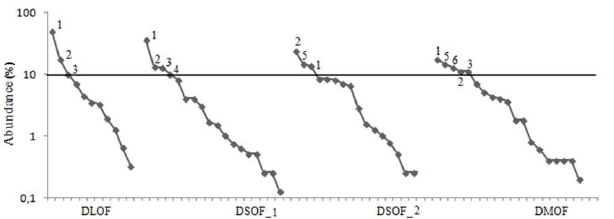
Fig 3. Rank abundance plot for Euglossini species in four areas in the Brazilian Atlantic forest. DLOF: dense lowland ombrophilous forest), DSOF_1: dense submontane ombrophilous forest, area 1, DSOF_2: dense submontane ombrophilous forest, area 2, DMOF: dense montane ombrophilous forest. 1: Euglossa cordata 2: Euglossa ignita 3: Eulaema atleticana 4: Euglossa imperialis ; 5: Euglossa milenae ; 6: Eulaema